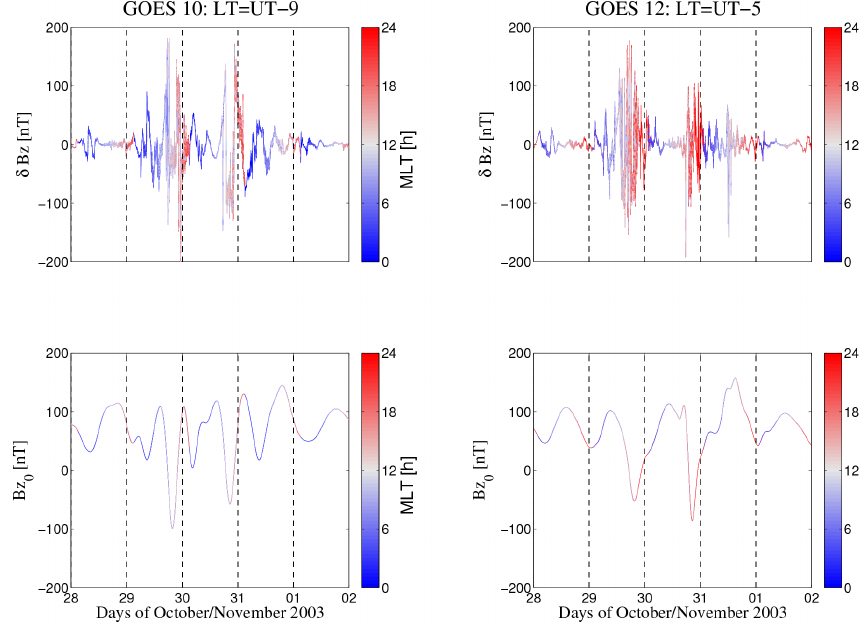
Figure 16. Halloween super storm, 28 October–1 November 2003: EMD reconstruction for GOES10 (left panels) and GOES12 (right panels) geosynchronous observations. The time resolution is